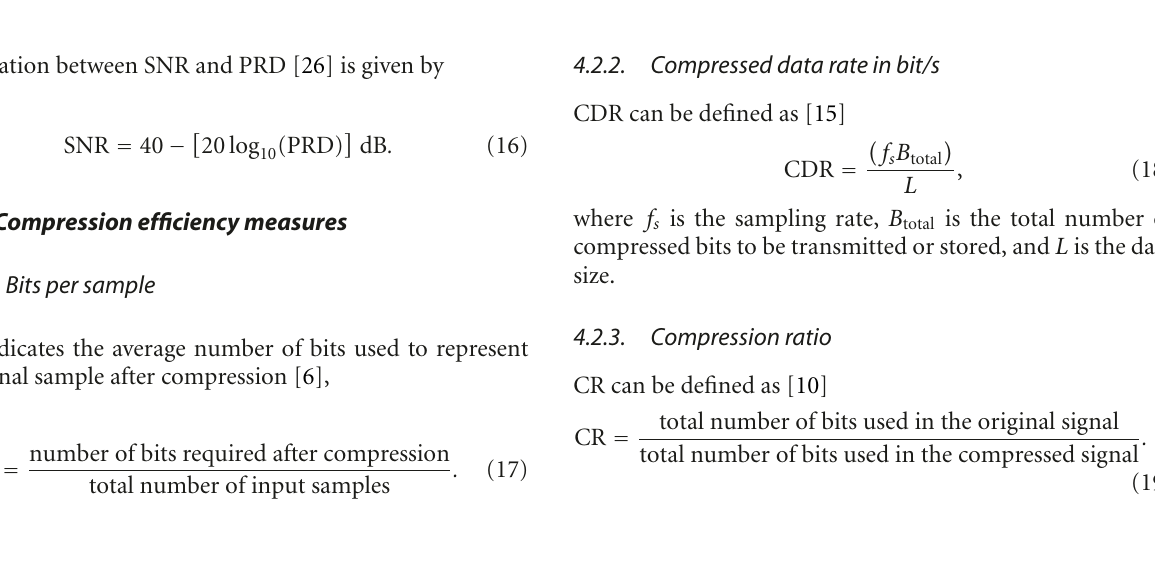
Figure 10: Results with floating-point and fixed-point representations for the trained weights and biases with PH scheme using (a) ABT and (b) SBT; and with PRH scheme using (c) ABT and (d)